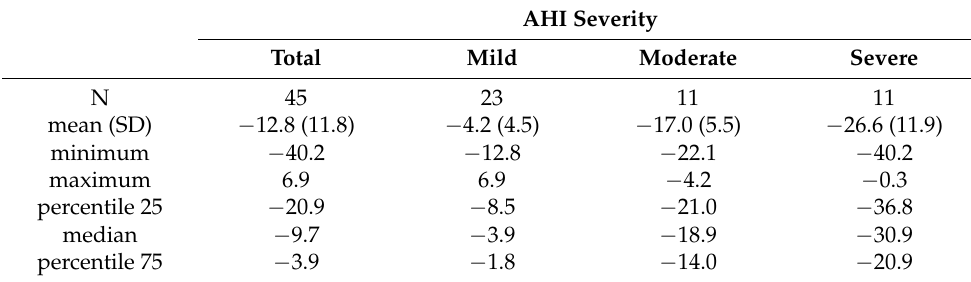
Figure 4. Significant differences between the three groups are found ( p < 0.001) through Kruskal– Wallis test. Those patients who are worse off are those who improve the most. Table 2. AHI changes once the MAD was titrated according to AHI